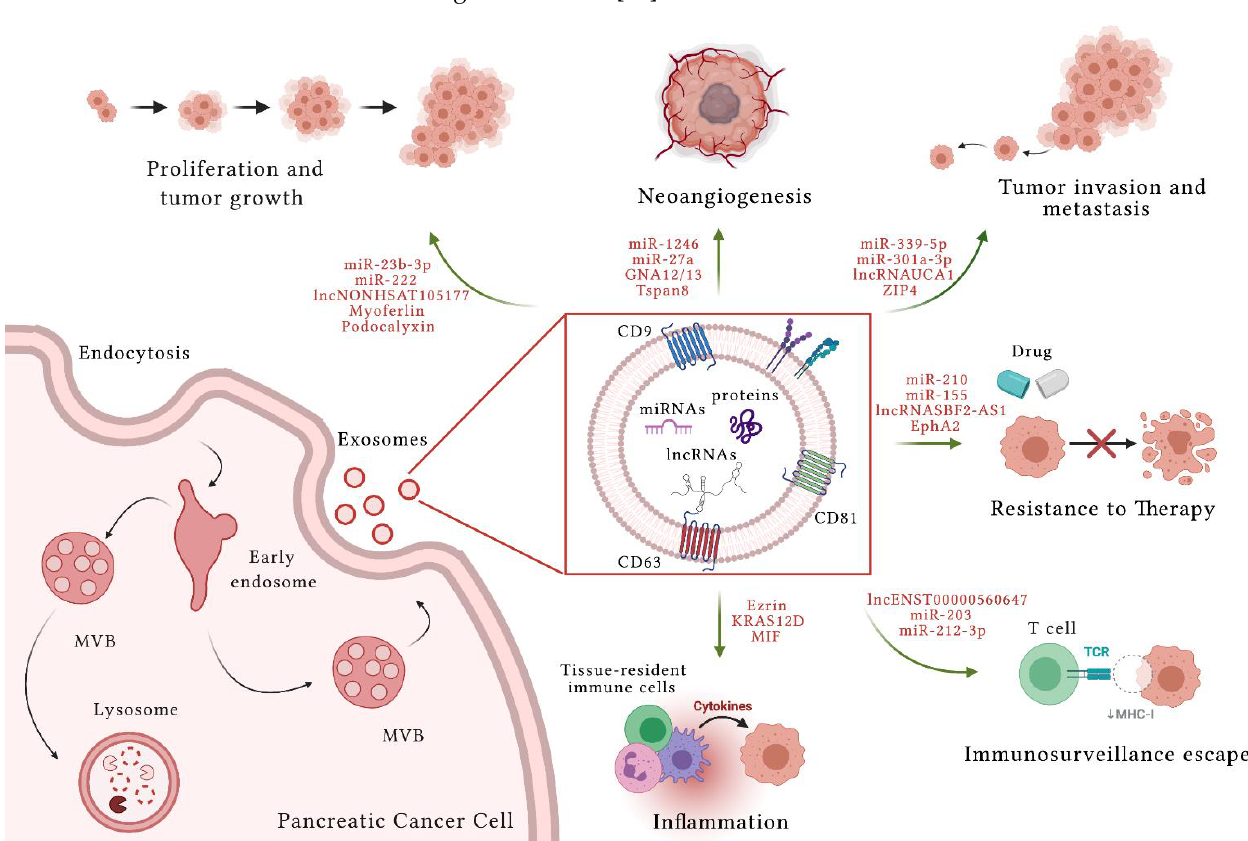
Figure 1. Role of extracellular vesicles (EV) in pancreatic cancer. Exosomes are subset of EVs. They originate after the fusion of multivesicular bodies (MVBs) with plasma membrane and the release of ILVs (Intraluminal vesicles) into extracellular space. The content of EVs determines their functions. EVs originated from pancreatic cancer (PC) cells deliver different functional biomolecules, such as micro RNAs (miRNAs), long noncoding RNAs (lncRNAs), and several proteins. In the figure examples of EV content are indicated. EVs play a pivotal role in PC progression. In fact, they are involved in proliferation and tumor growth, in the mechanisms of angiogenesis, in invasion and metastasis processes, in the induction of chemoresistance, in the escape of cancer immunosuppression, and in inflammation that creates a conducive microenvironment to cancer progression. Created with BioRender.com accessed on 20 May 2021.